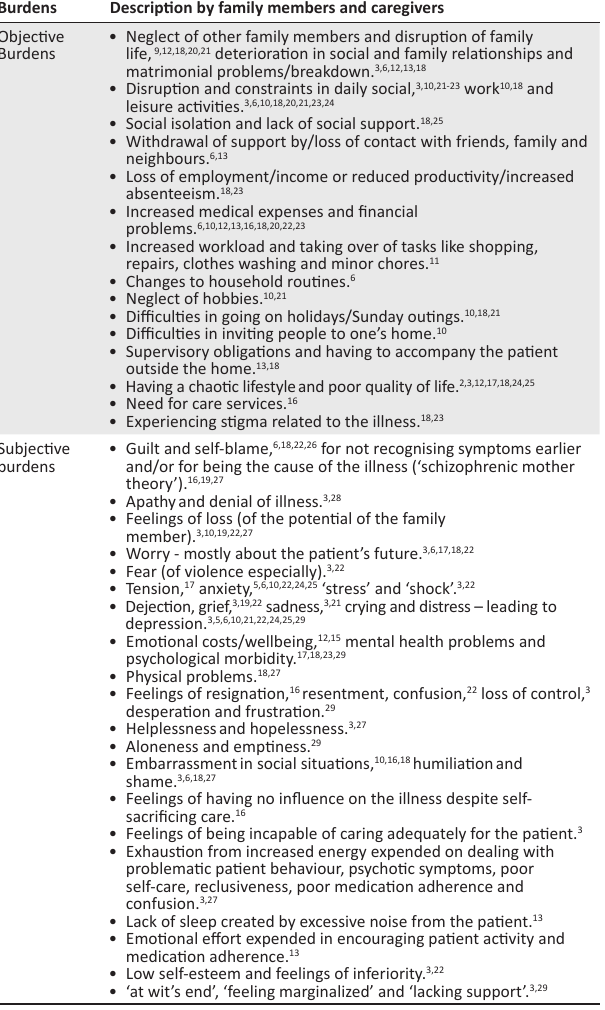
TABLE 1: Examples of objective and subjective burden as experienced, and described, by family members or caregivers.